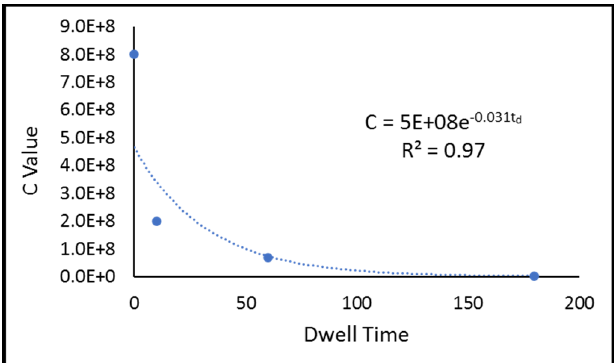
Figure 15. Constant ( C ) as a function of dwell time.